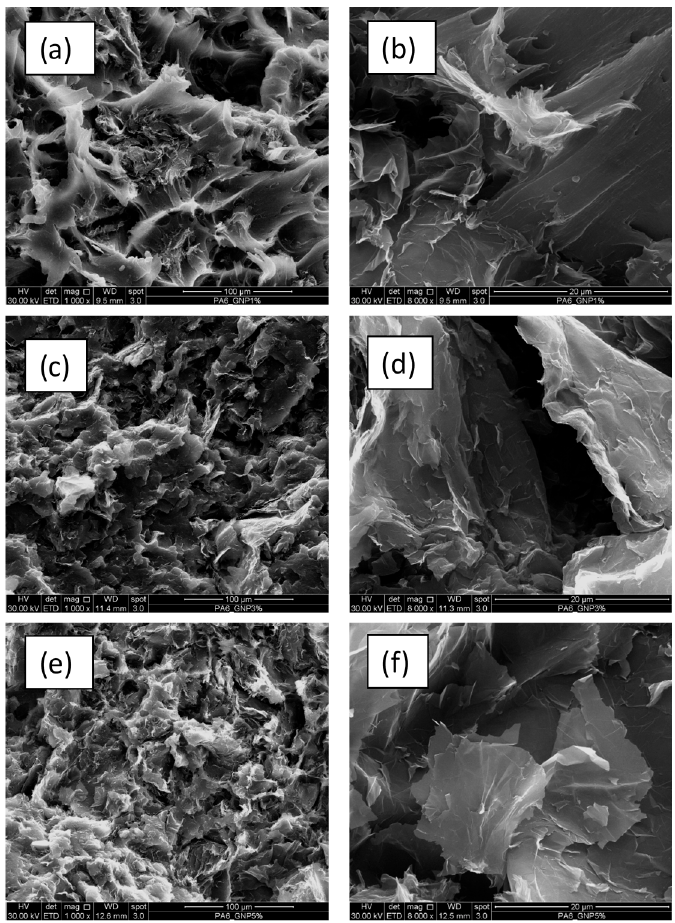
Figure 6. SEM micrographs collected at two different magnifications (1000× and 8000×) for PA6 compounds with different content of GNPs ( a , b ) 1 wt%, ( c , d ) 3 wt%, and ( e , f ) 5 wt%, respectively.